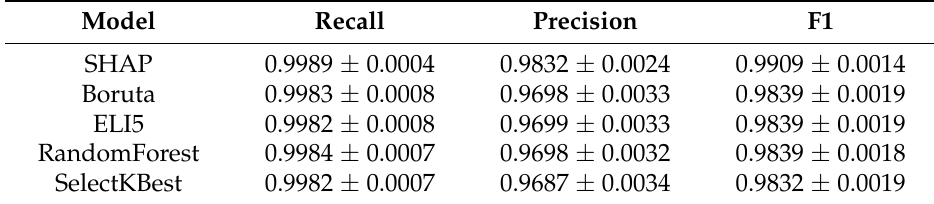
Table 5. Performance comparison of SHAP and other feature selection methods.